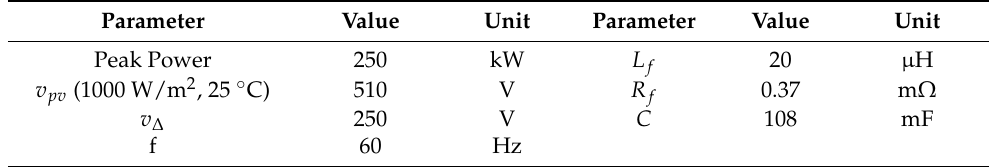
Figure 5. Simulation of a single-stage PV farm following a change in solar irradiance: ( a ) irradiance profile; ( b ) DC voltage response; ( c ) Power response. Table 1. Single-stage PV farm system